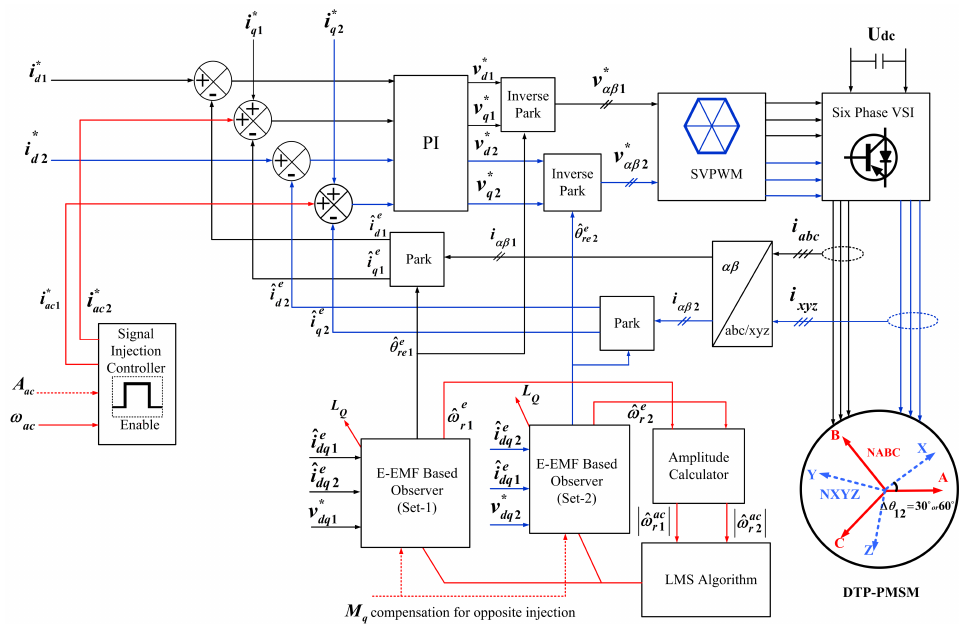
Figure 17. Overall block diagram of DTP-PMSMs control system with combination methods